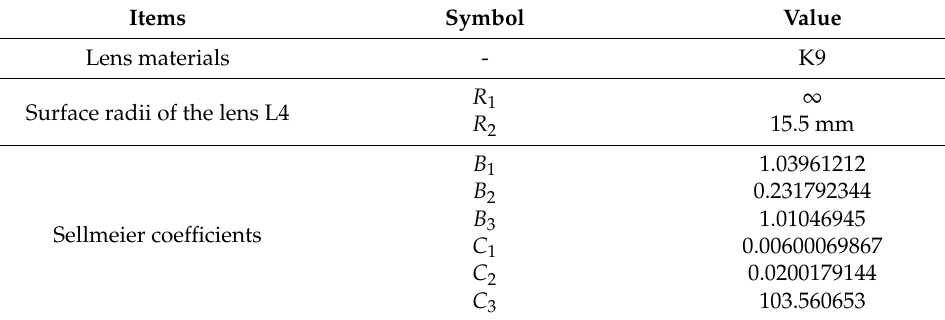
Table 1. Physical parameters of the dispersive lens. Items